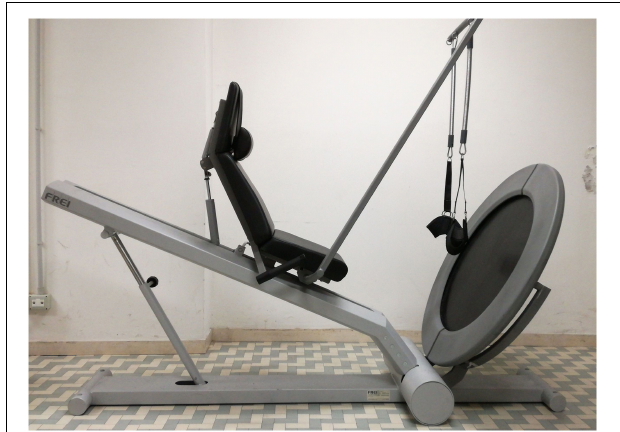
FIGURE 1 | Tramp Trainer exercise